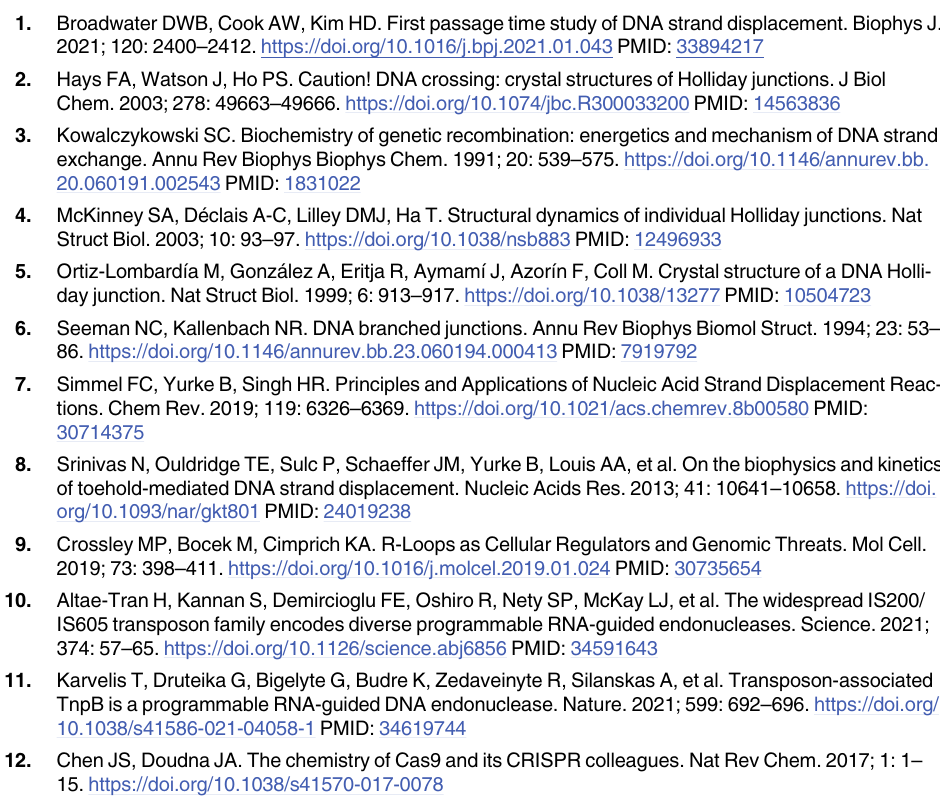
S3 Fig. Nucleotide torsion angles for Molecules 2 and 3. Analogous to Fig